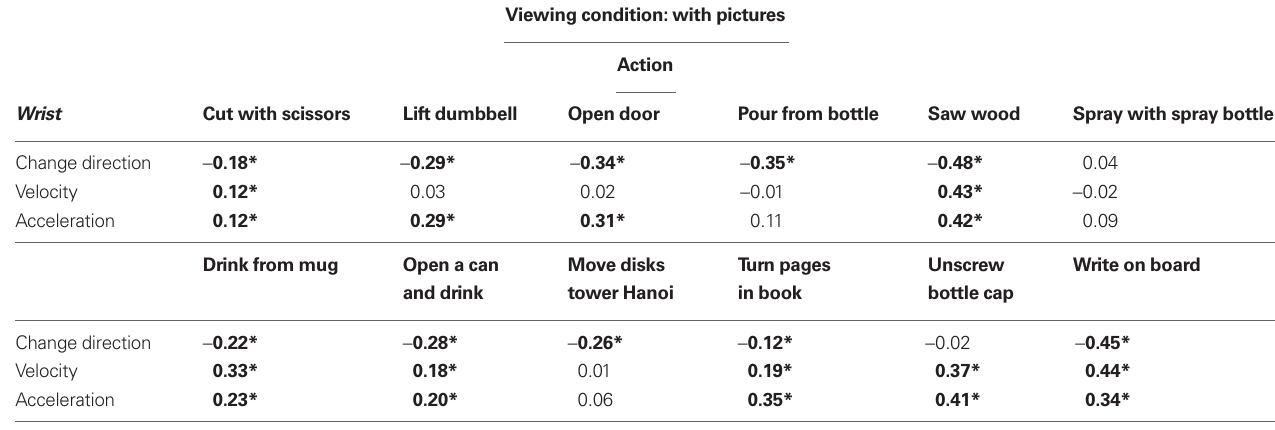
Table 4 | Correlations (Pearson r) between mark density function and kinematic variables measured from the wrist: change in direction of movement, velocity, and